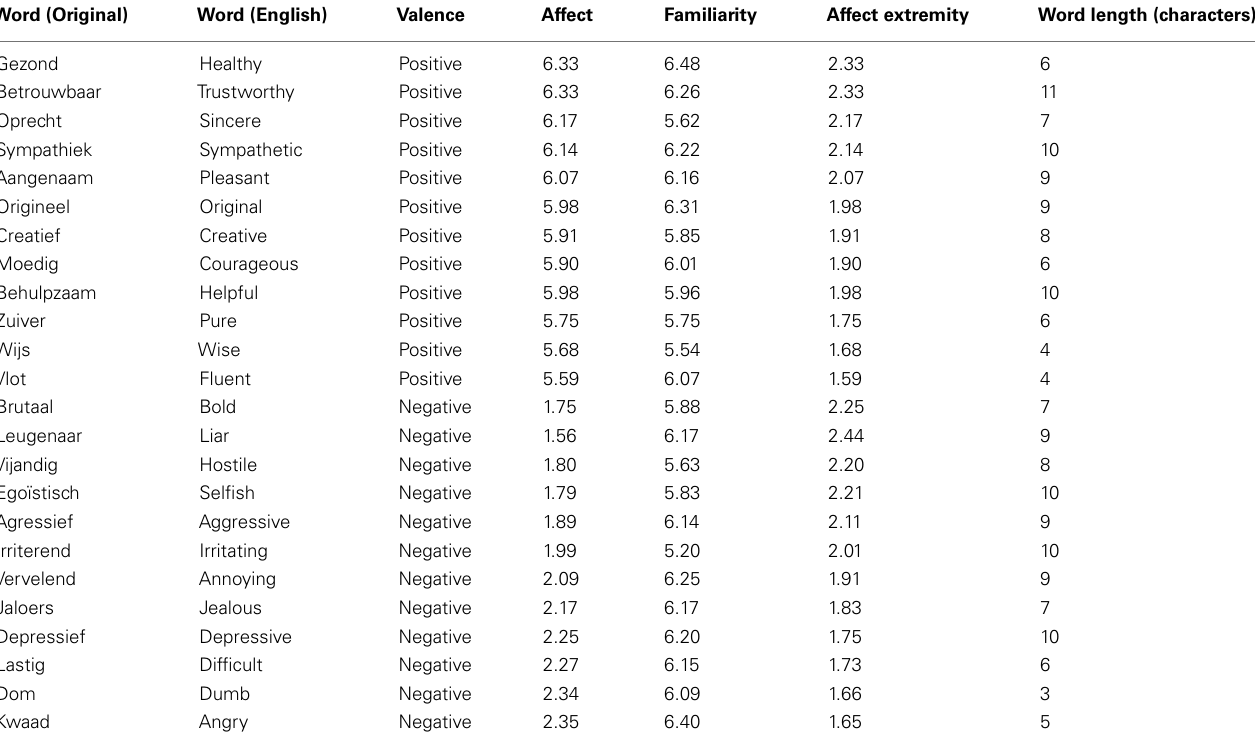
TableA3 |Valence category affect, affect extremity, familiarity, and word length of words used as targets in the affective priming task. Word